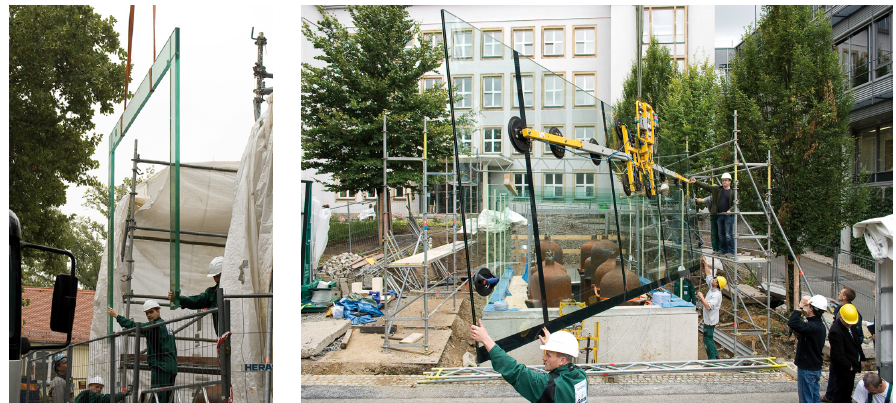
Figure 8: Glass frame erection. Figure 9: Installation of the large-sized lateral